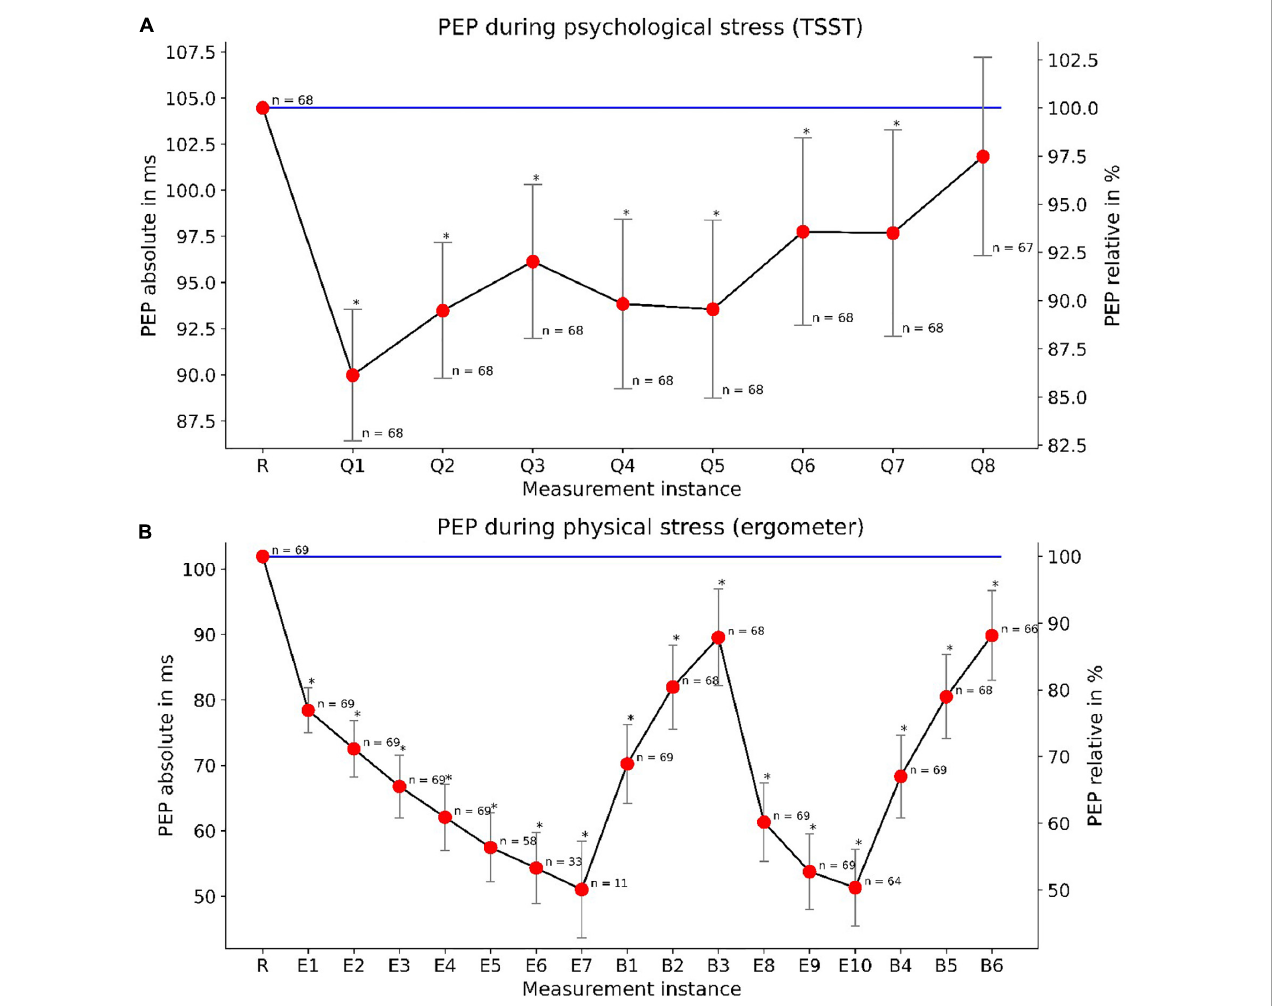
FIGURE4 PEP changes under mental (TSST) and physical (ergometer) load: The upper panel (A) depicts the PEP reactivity during the TSST. “R” marks the measurement at rest while “Q1”–“Q8” demark TSST questions. The lower panel (B) depicts PEP reactivity and load-response dependency under physical stress. “R” marks a measurement at rest, “E1”–“E10” demark measurements under physical load and “B1”–“B6” demark measurements during the break-period. We depicted PEP measurements taken at the end of their according BP measurements. Declining n -numbers are due to dropouts (during TSST) or reaching the maximum heart rate at earlier load steps (ergometer). Whiskers show confidence intervals ( p < 0.05) for relative PEP values. The absolute variance of PEP is more clearly depicted in Figure 8